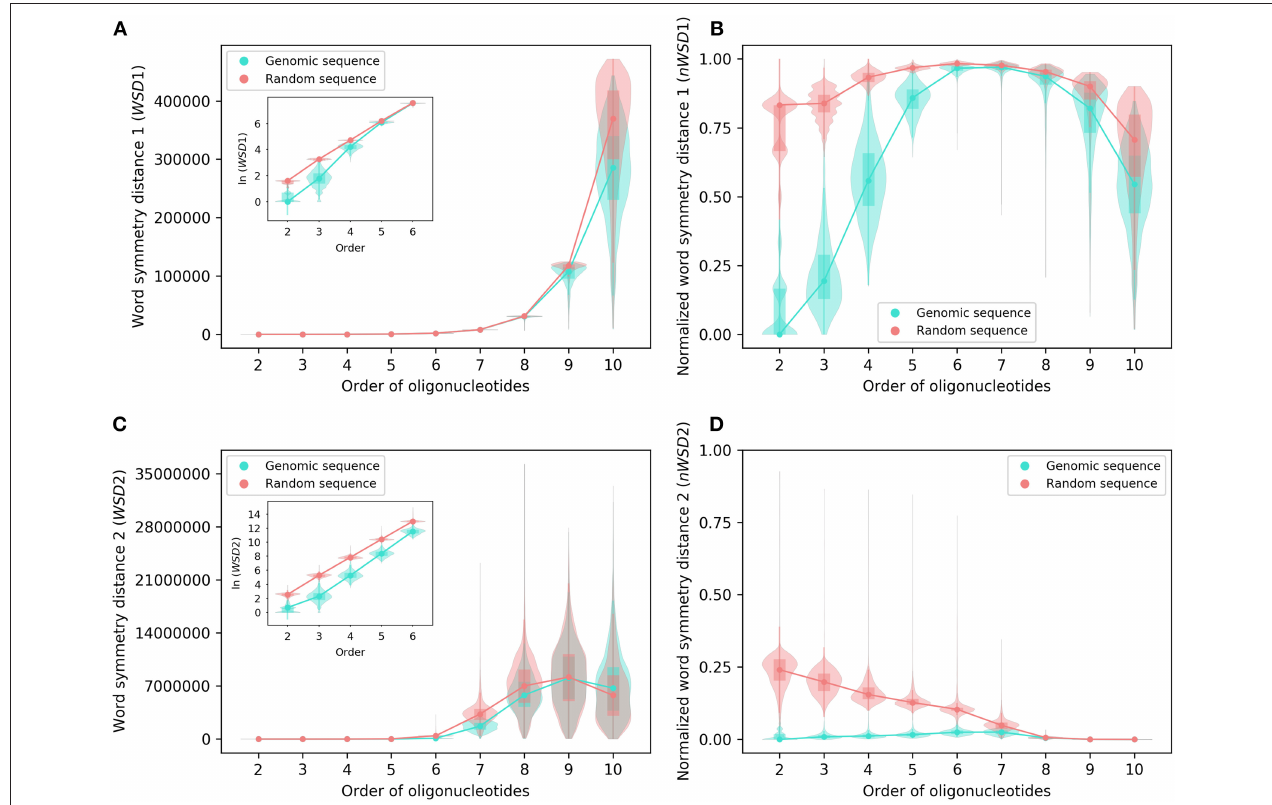
FIGURE 3 | Various word symmetry distances for 2,659 bacterial genomes and their corresponding random sequences. (A) WSD 1. (B) nWSD 1. (C) WSD 2. (D) nWSD 2. For other explanations see the legend of Figures 1 , 2